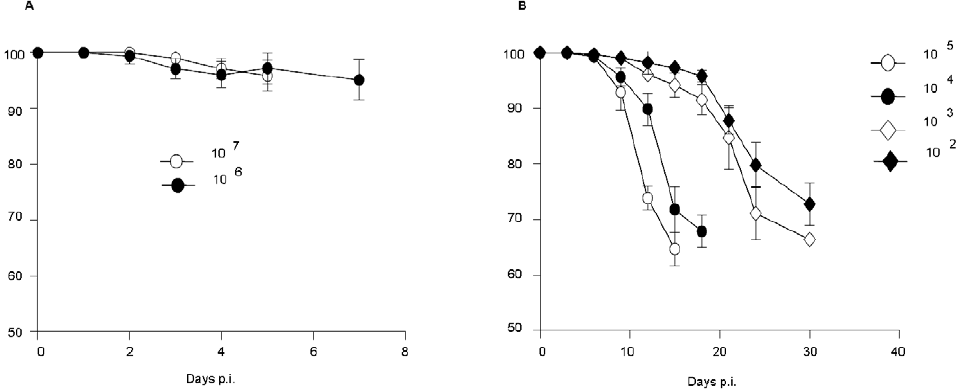
Figure 2. Body weight changes in D2Y98P-infected mice. Mice were ip. infected with 10 7 or 10 6 (A), or with 10 5 to 10 2 (B) PFU of D2Y98P. Body weight changes were monitored daily (A) or every other day (B) post-infection (p.i.). Results are expressed as the [mean 6 SD] of body weight loss in percentage compared to initial body weight. Ten mice per group were monitored. Results are representative of 2 independent experiments.